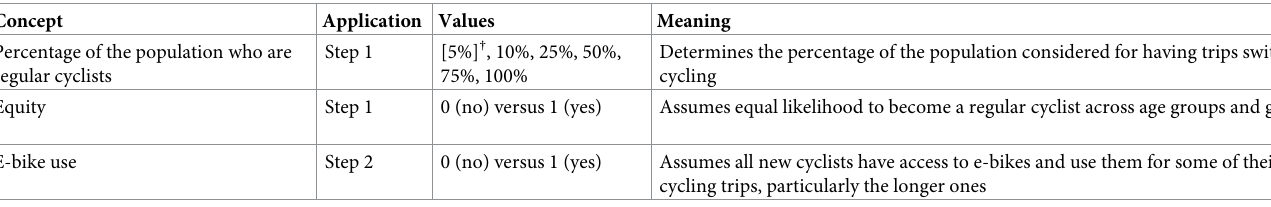
Table 1. Three core parameters used to create impacts of cycling tool